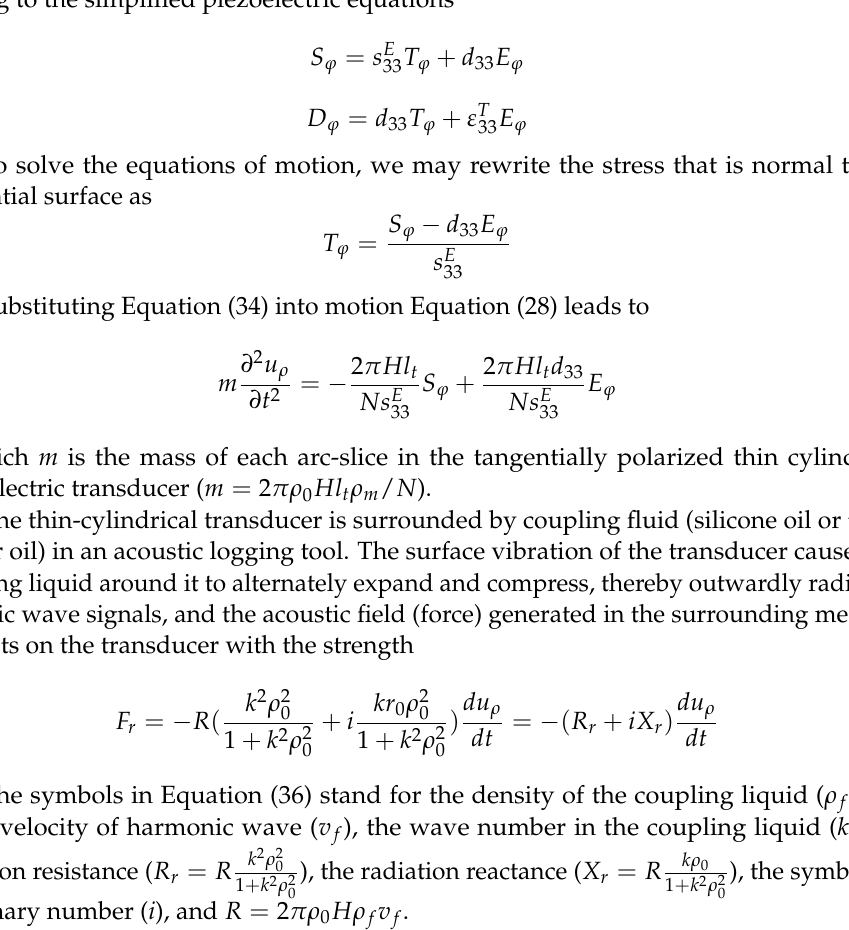
Figure 3. Tangentially polarized thin cylindrical piezoelectric transducer. ( a ) Stereogram; ( b ) Top view.